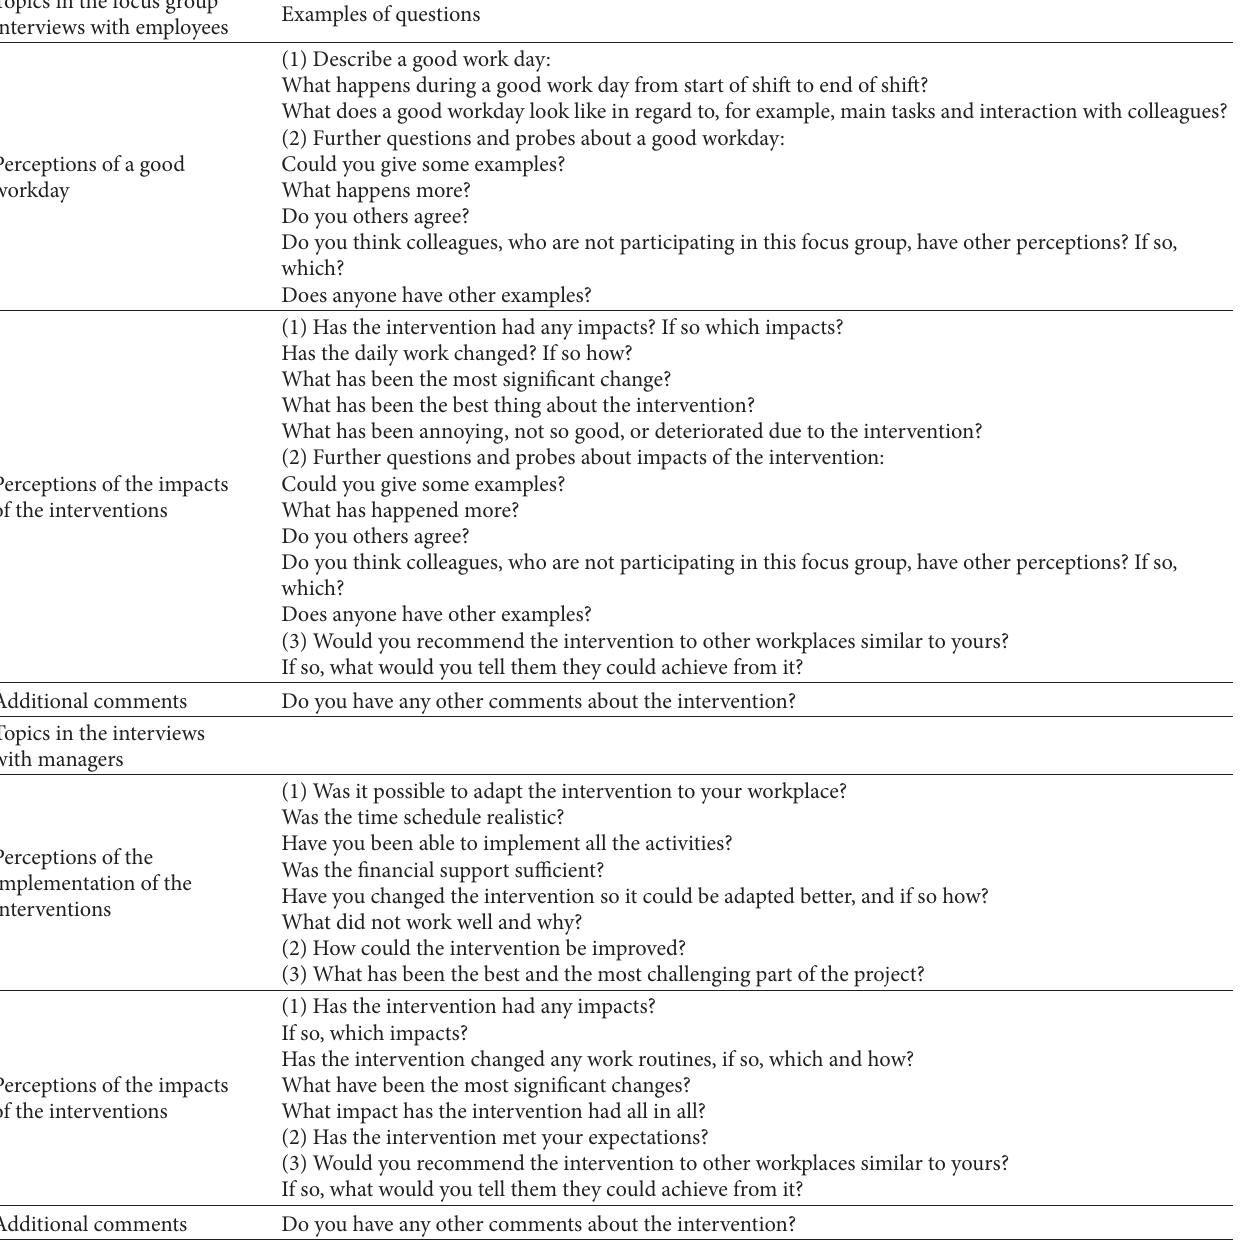
Table 1: Topics in the interviews with employees and